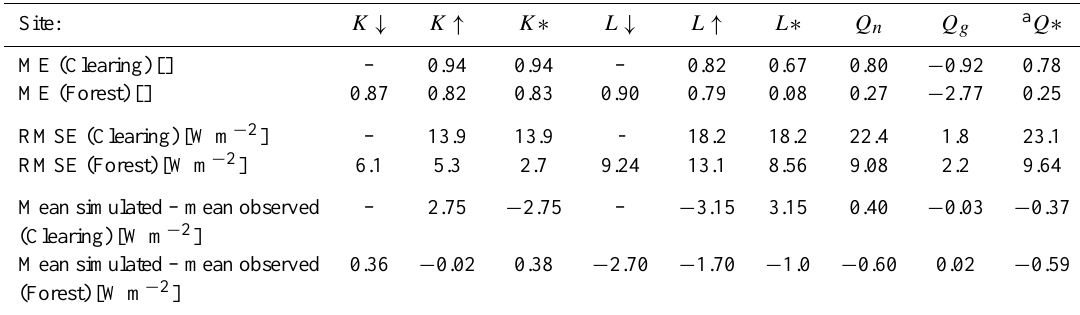
Table 5. Model efficiency index (ME), root mean square error (RMSE), and the difference between mean simulated and observed values of: shortwave irradiance ( K ↓ ), reflected shortwave irradiance ( K ↑ ), net shortwave radiation ( K ∗ ) , longwave irradiance ( L ↓ ), longwave exitance ( L ↑ ), net longwave radiation ( L ∗ ) , total net radiation ( Q n ) , net ground heat flux ( Q g ) , and total energy to snow ( Q ∗ ) (i.e. Q * = Q m + dU/d t) for pine forest and clearing sites at Marmot Creek, Alberta,